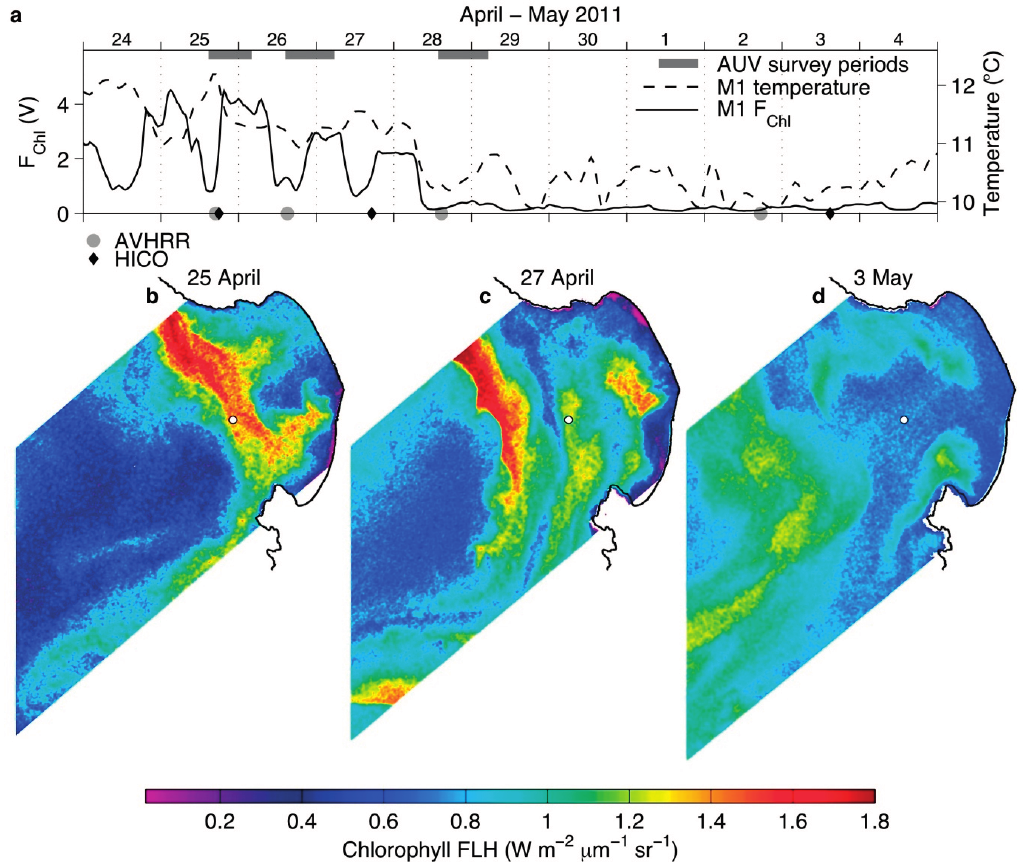
Figure 4. Spring 2011 study: Changes in local and regional conditions associated with upwelling intensification (Figure 3). ( a ) Measurements from 1 m depth at mooring M1; F Chl is raw signal from the chlorophyll fluorometer. ( b – d ) FLH computed using HICO bands nearest those of MODIS FLH (Table 1); the white circle indicates M1